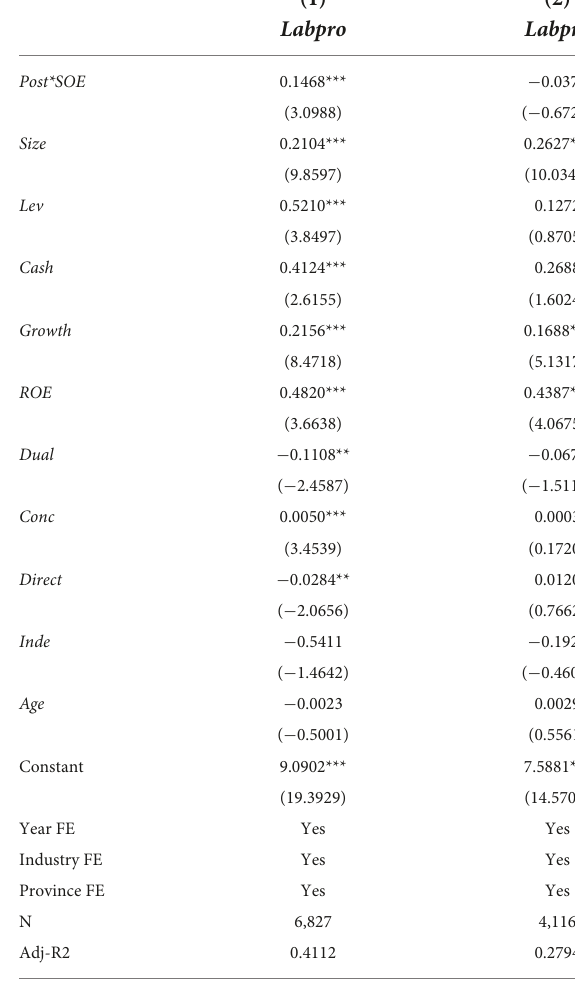
TABLE 6 The result of the mechanism analysis. TABLE 7 Monopolistic industries vs. competitive